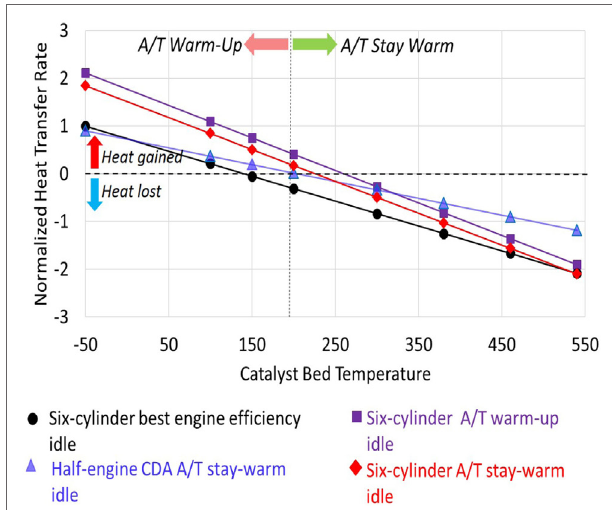
FigUre 9 | Estimated normalized heat transfer results for the four strategies at 800 RPM/1.3 bar. Catalyst warm-up is fastest during the “Six-cylinder A/T warm-up idle” strategy. Once catalyst temperatures reach desirable temperature (e.g., 300 deg. C), the “Half-engine CDA A/T stay-warm idle” strategy is preferred given its lower exhaust flow rate, and elevated engine-outlet